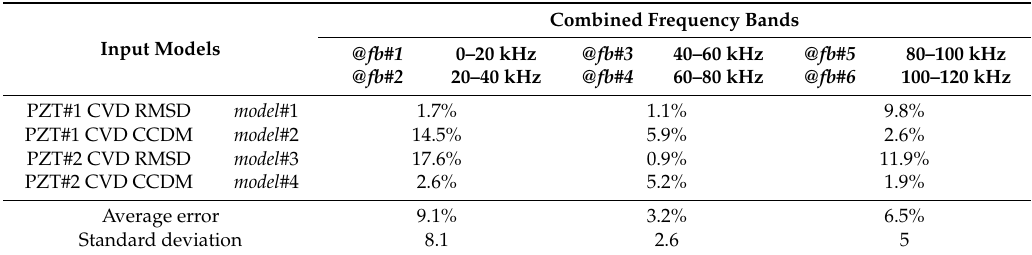
Table 3. Main characteristics of the ANN models in experimental test case #1.